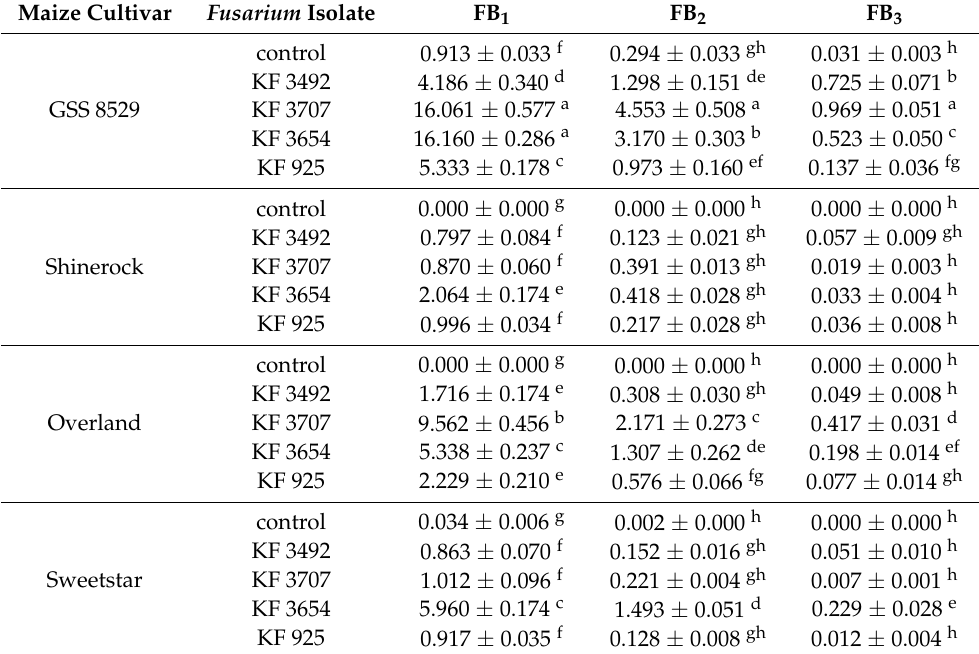
Table 1. Mycotoxin content [ µ g/g] in four maize cultivars inoculated with Fusarium